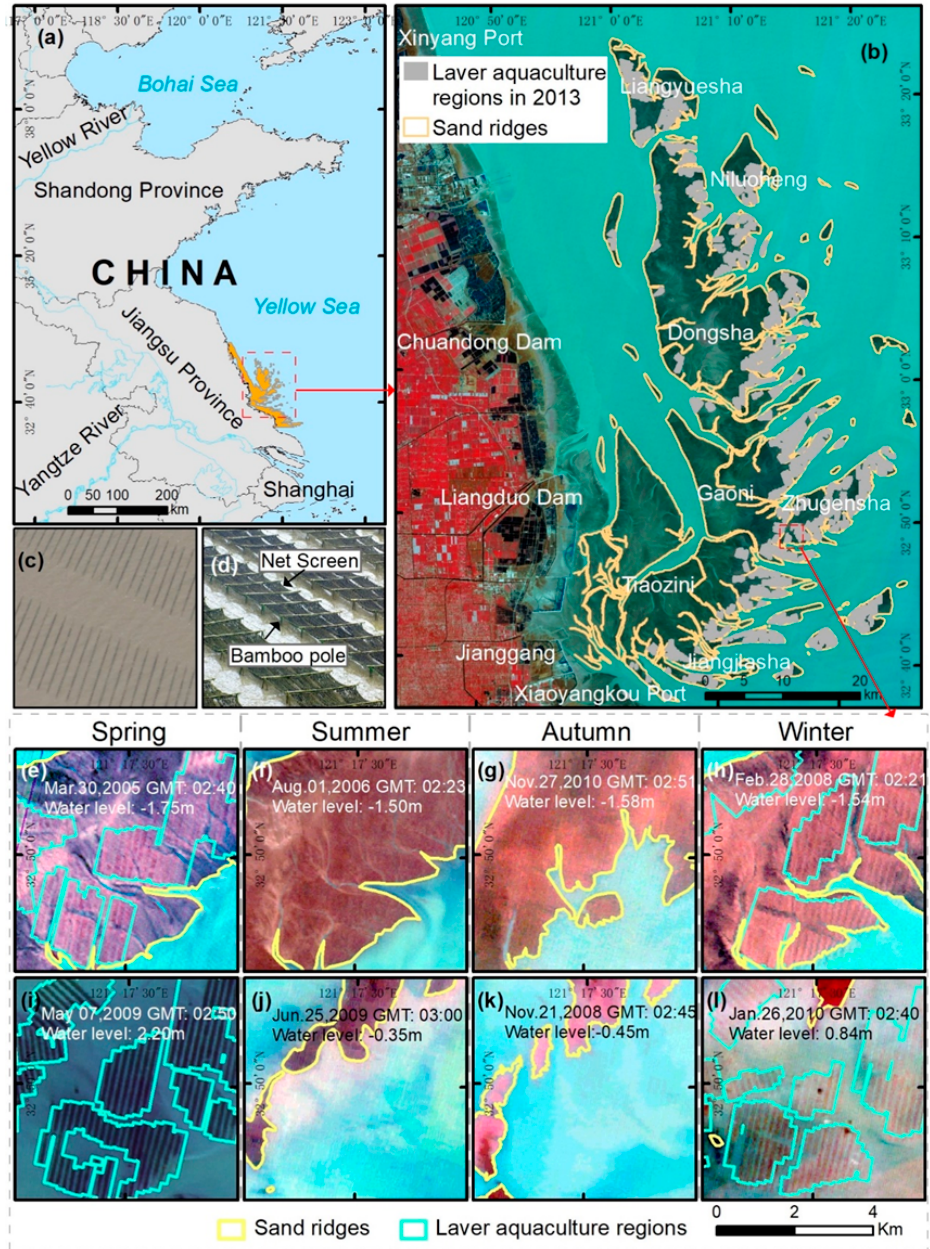
Figure 1. Location and distribution of laver cultivation regions in the central Jiangsu coast. ( a ) The location of the central Jiangsu coast; ( b ) optical image with standard false coloring of the central Jiangsu coast taken by HJ-1B CCD on 1 January 2013 and the laver aquaculture regions in 2013; ( c ), ( d ) the laver aquaculture regions observed from Google Earth and field investigations; ( e )–( h ), (i)–( l ) the aquaculture regions observed from optical images with low and high water levels taken in spring, summer, autumn and winter, respectively. The datum of water levels is the mean sea level.